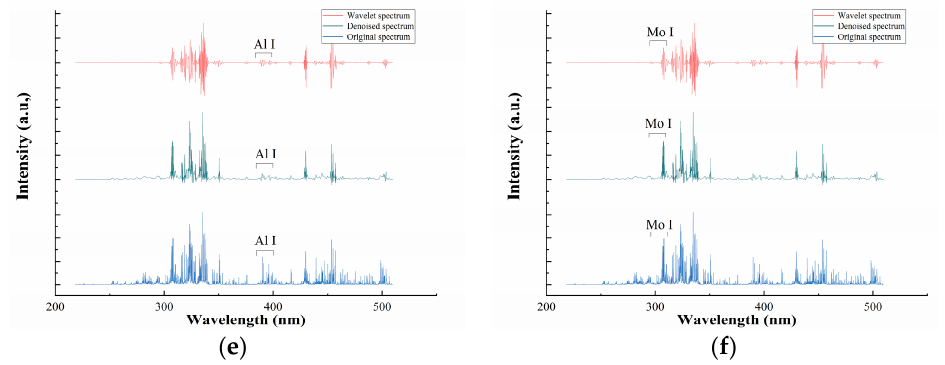
Figure 5. LIBS signals of six samples characteristic lines. ( a ) 42CrMo, ( b ) A100, ( c ) GH4169, ( d ) TC4, ( e ) TC11; ( f ) TC17.